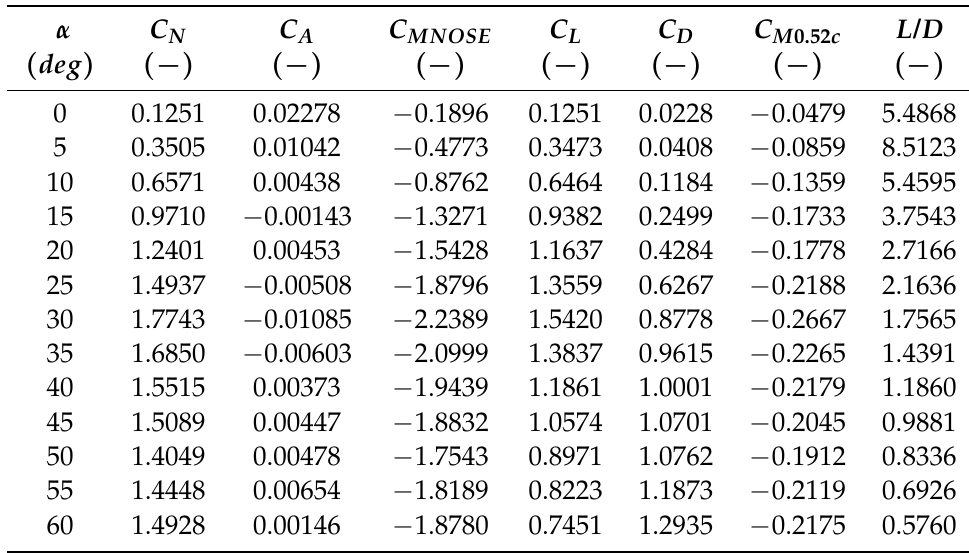
Figure 9. Flowfield results at α = 20 ◦ . Pressure distribution ( left ) and vorticity magnitude ( right ). Table 2. Aircraft